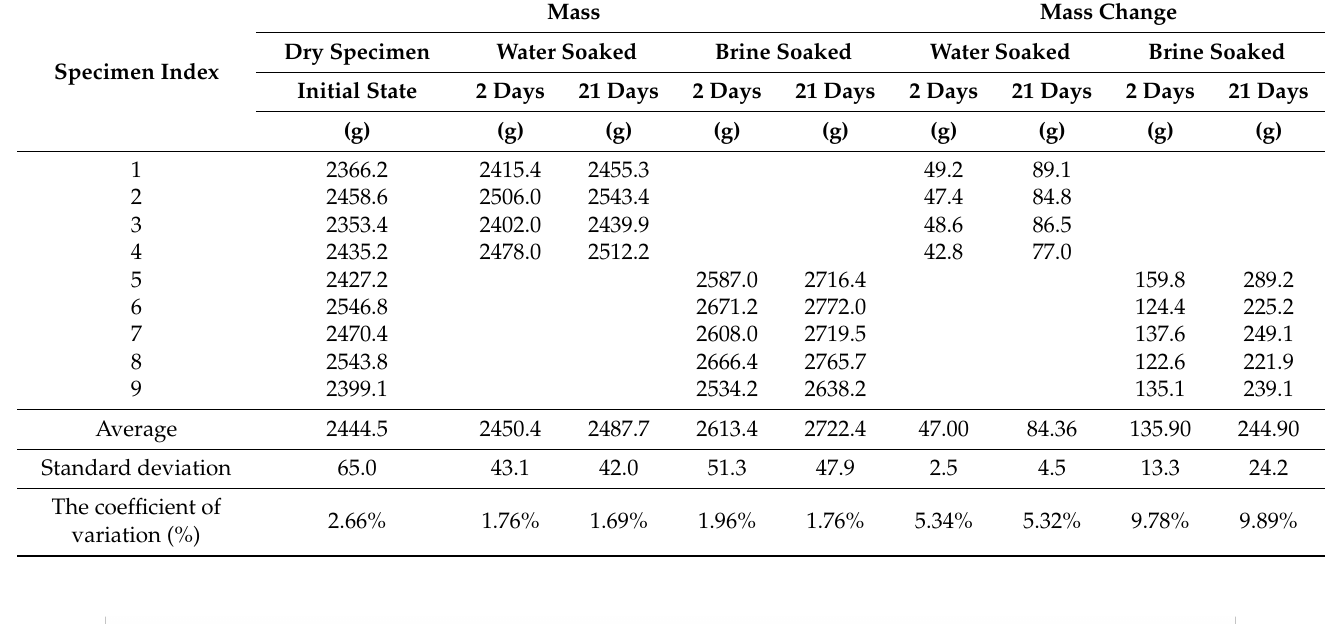
Table 9. Mass variability of MCAS via soaking in water and brine.